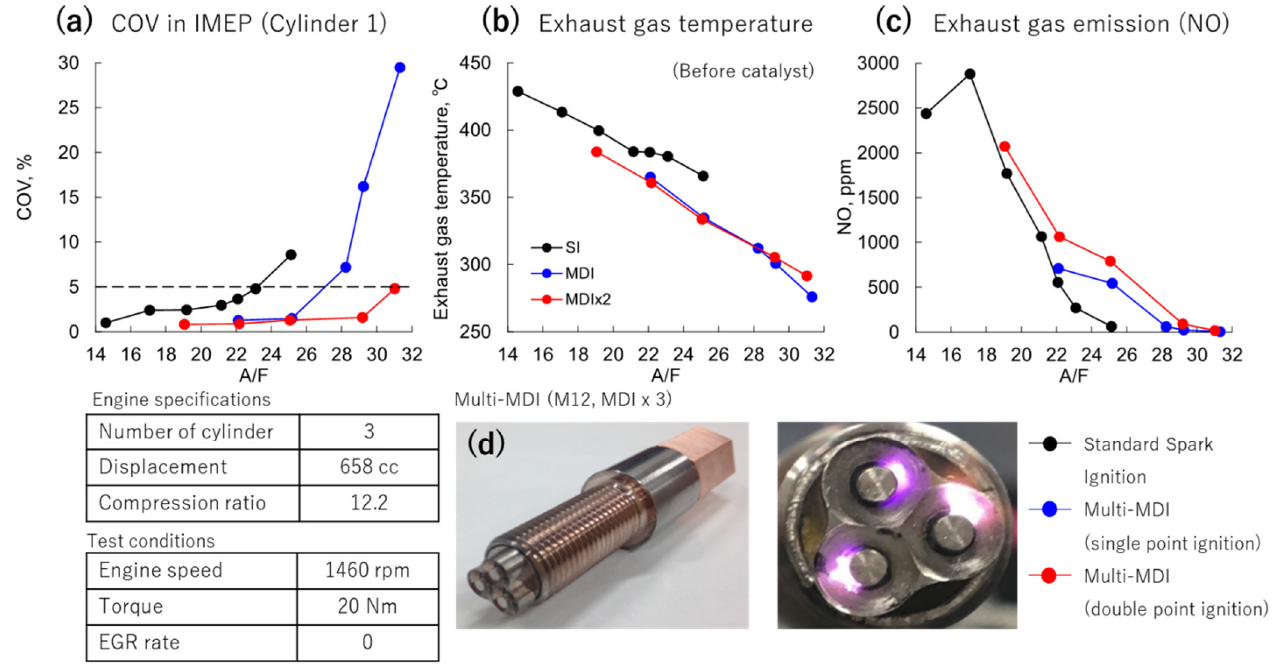
Figure 12. Comparison of ( a ) coefficient of variation (COV), ( b ) exhaust gas temperature, and ( c ) NO production in standard spark plugs, single-point microwave discharge igniter (MDI), and double point MDI. ( d ) Actual images of used multi-MDI.